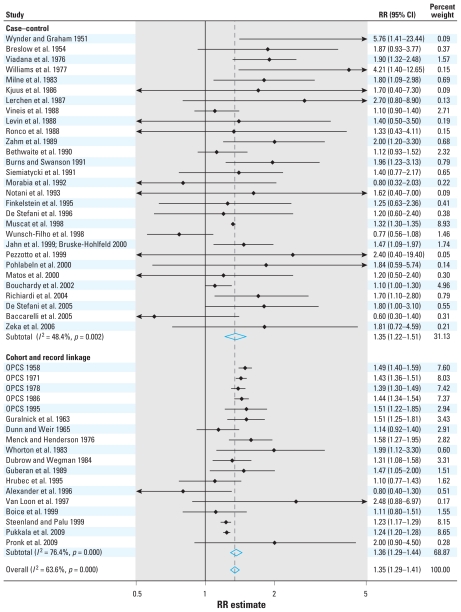
Meta-analysis of all studies assessing lung cancer among persons with occupation as a painter, stratified by study design. Weights are from random-effects analysis. The relative risk estimate for each study is represented by a black diamond, and the horizontal line shows the corresponding 95% CI. The dashed line marks the combined estimate, and the vertical solid line represents no association.